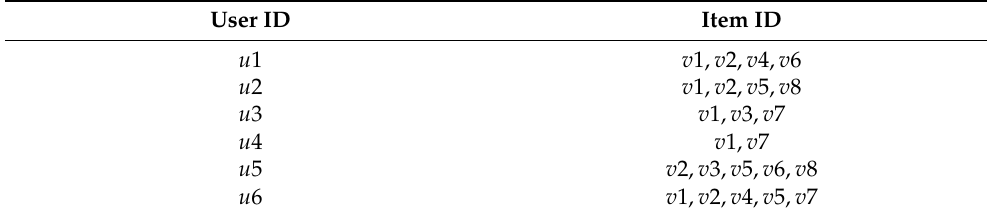
Table 3. User transaction record